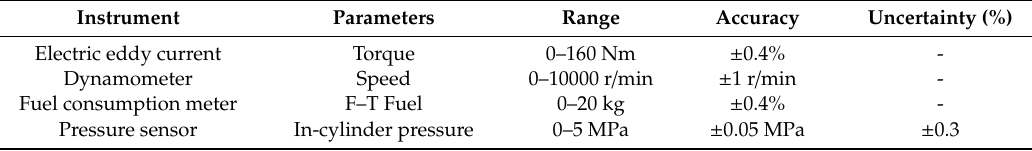
Table 3. Accuracy and uncertainty of the measuring